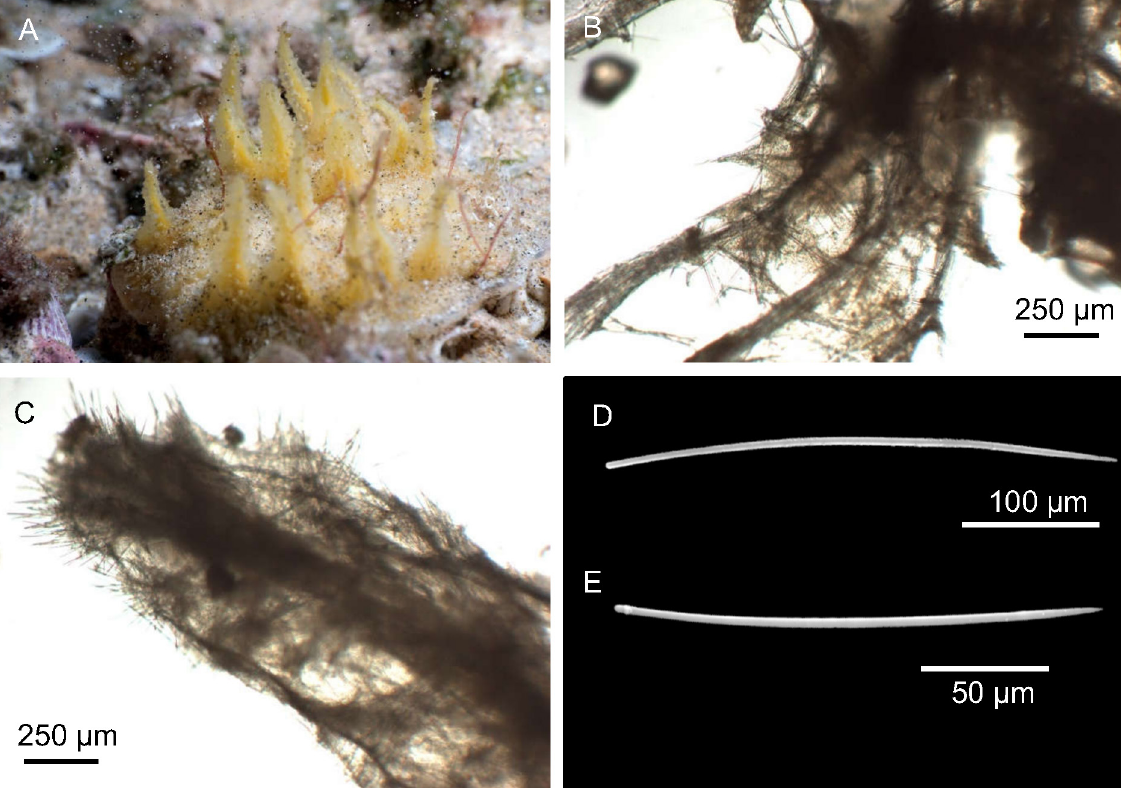
Fig. 24. Ciocalypta heterostyla Hentschel, 1912. A . Fistules erect, coming out the sediment (PO63). B . Skeleton of the basal part. C . Skeleton of fistules. D–E .